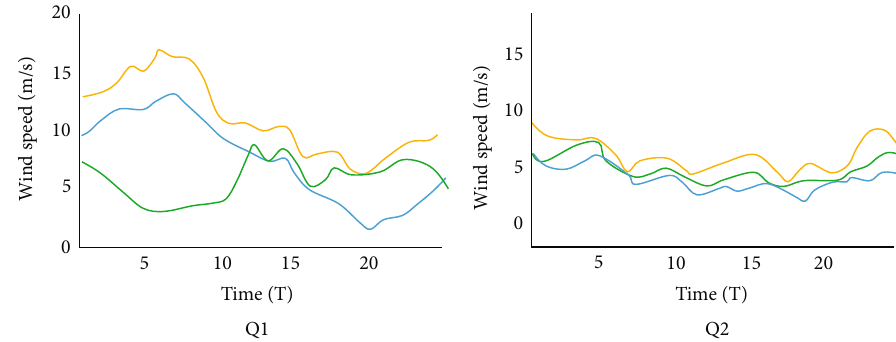
Figure 7: Variation of wind speed at high, medium, and low levels under di ff erent load